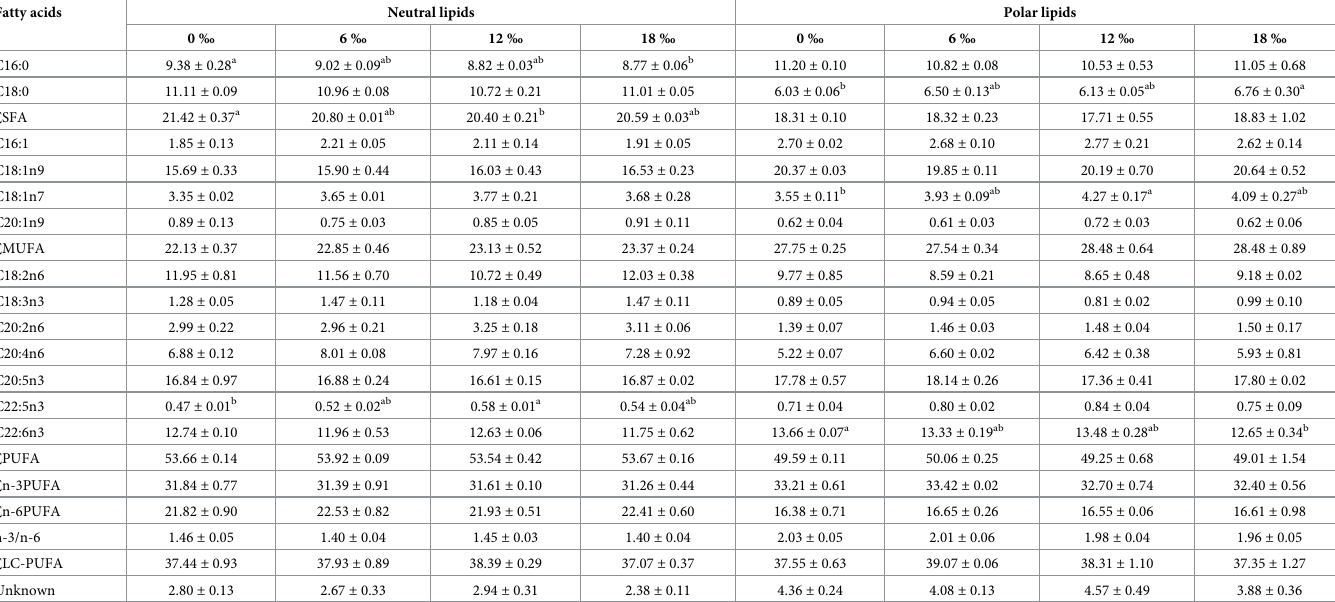
table. ∑ SFA: total saturated fatty acids; ∑ MUFA: total monounsaturated fatty acids; ∑ PUFA: total polyunsaturated fatty acids; ∑ LC-PUFA: total long chain polyunsaturated fatty